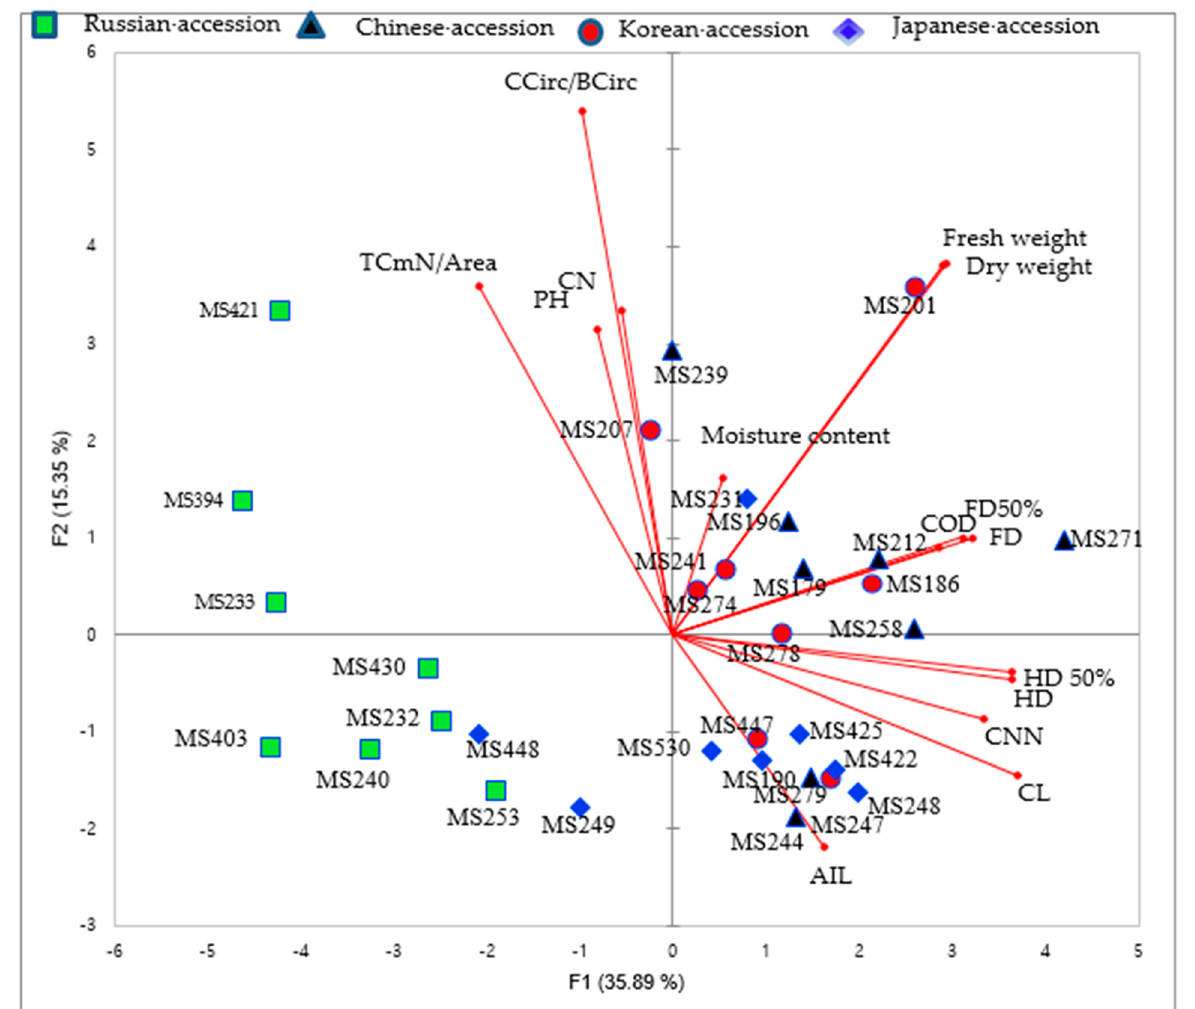
Figure 1. Two-dimensional plot of PC1 and PC2 principal coordinates analysis in the selected accessions of M. sacchariflorus based on morphological traits. COD: culm out diameter, CNN: culm node number, AIL: average internode length, CCirc: compressed plant circumference, BCirc: basal circumference, TCmN: total culm node number. 1 HD: first heading date, HD 50%: 50% heading date, FD: first flowering date, FD 50%: 50% flowering date, CN, culm number; TC: total culm; CL: culm length, PH: plant height, TCmN, total culm node number.